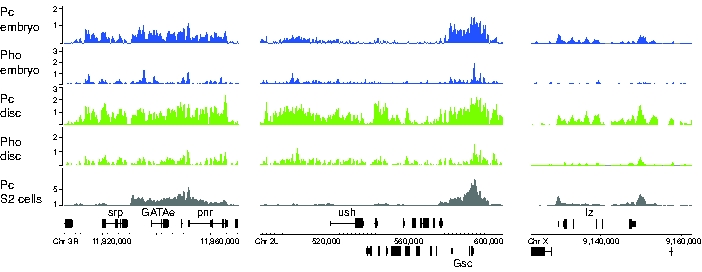
Binding profiles for haemocyte lineage genes.The srp and ush genes expressed in S2 cells show Pc and Pho binding in embryos and imaginal disc but do not show Pc binding in S2 cells. Nearby genes provide positive controls (e.g. Gsc in the case of ush) and note the sharp boundary between Pc binding at srp and the neighbouring GATAe gene. The lz gene is not expressed in S2 cells and is associated with Pc binding.